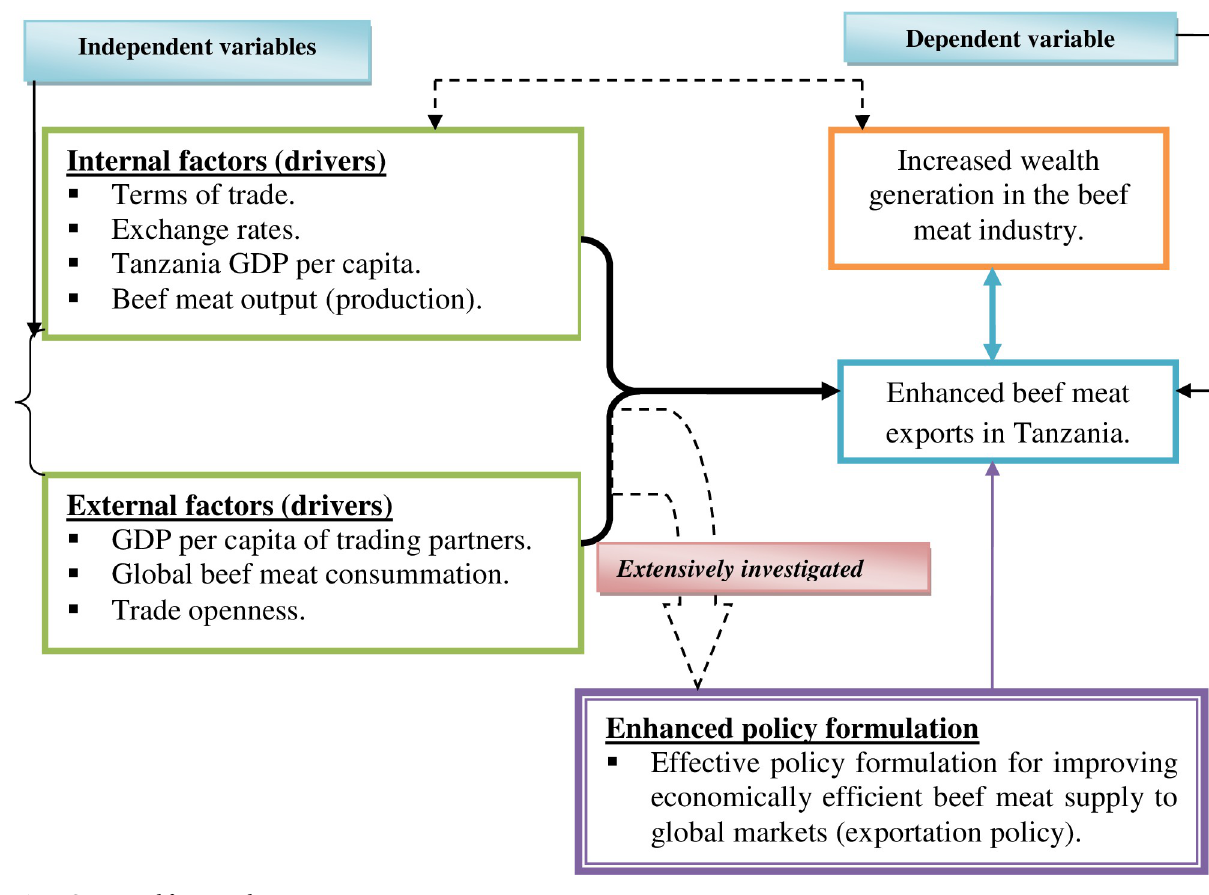
Fig 1. Conceptual framework.